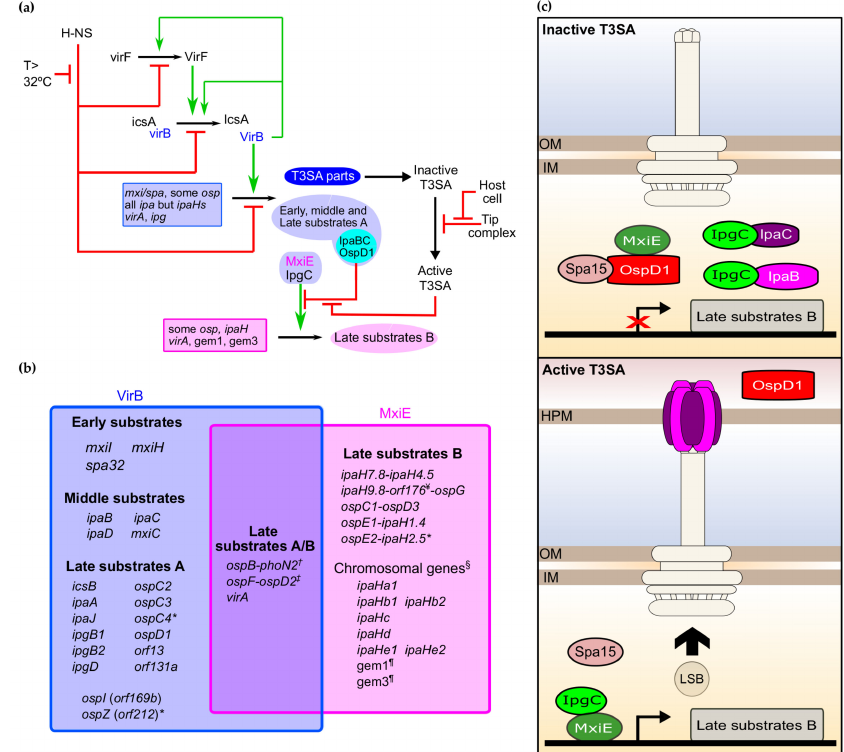
Figure 3. The transcription regulatory cascade of the T3SA. ( a ) Key transcriptional regulatory cascade of the type III secretion system (T3SS) in Shigella . ( b ) The VirB and MxiE regulons; this figure is inspired from a prior version [95], and updated to take into account the most recent findings [58,96]. * These are likely pseudogenes in strain M90T; † this gene belongs to the VirB and MxiE regulon but its product is not a T3SA substrate; ‡ this gene is weakly expressed and a new addition to the MxiE regulon; § the chromosomal ipaH s are annotated according to [97]; ¶ whether the product of these genes are T3SA substrates is currently unknown; ¥ this gene encodes an antitoxin from a TA system that is weakly secreted by the T3SA. Note that other antitoxin coding genes gmvA (orf48), orf86, and mvpA , which are not part of these two regulons, were also suggested to be T3SA substrates [58]. ( c ) Heteromers formed by MxiE and IpgC in the inactive and active state of the T3SA and their e ff ect on the transcription of late substrates